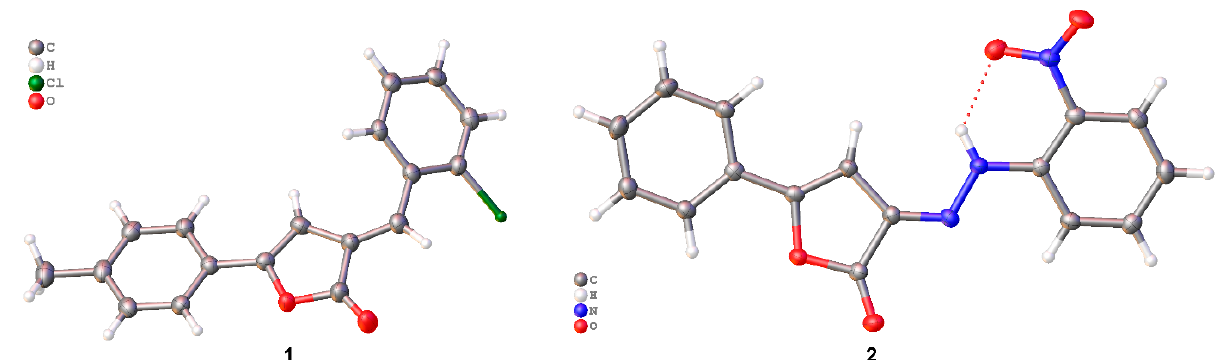
Figure 1. General view of molecules: non-flat arylidene ( 1, current study) and flat hydrazone ( 2 ) derivatives of furan- 2(3 H )-one in a crystal. Atoms are represented by thermal vibration ellipsoids ( P = 50%). The H-bond is indicated by a dotted line.